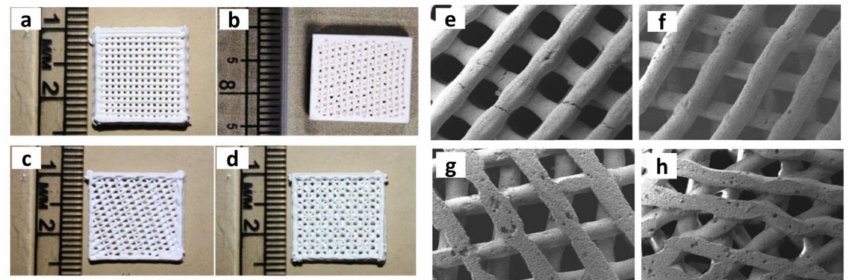
Figure 8. Photographs ( a – d ) and SEM images ( e – h ) of Sintered β -TCP/zirconia scaffolds with different laydown patterns and ( a , e ) 0 ◦ –90 ◦ , ( b , f ) 0 ◦ –72 ◦ –144 ◦ –36 ◦ –108 ◦ , ( c , g ) 0 ◦ –108 ◦ –216 ◦ and ( d , h ) 0 ◦ –45 ◦ –90 ◦ –135 ◦ , respectively. Reprinted with permission Images used from Sapkal et al. [79], copyright©